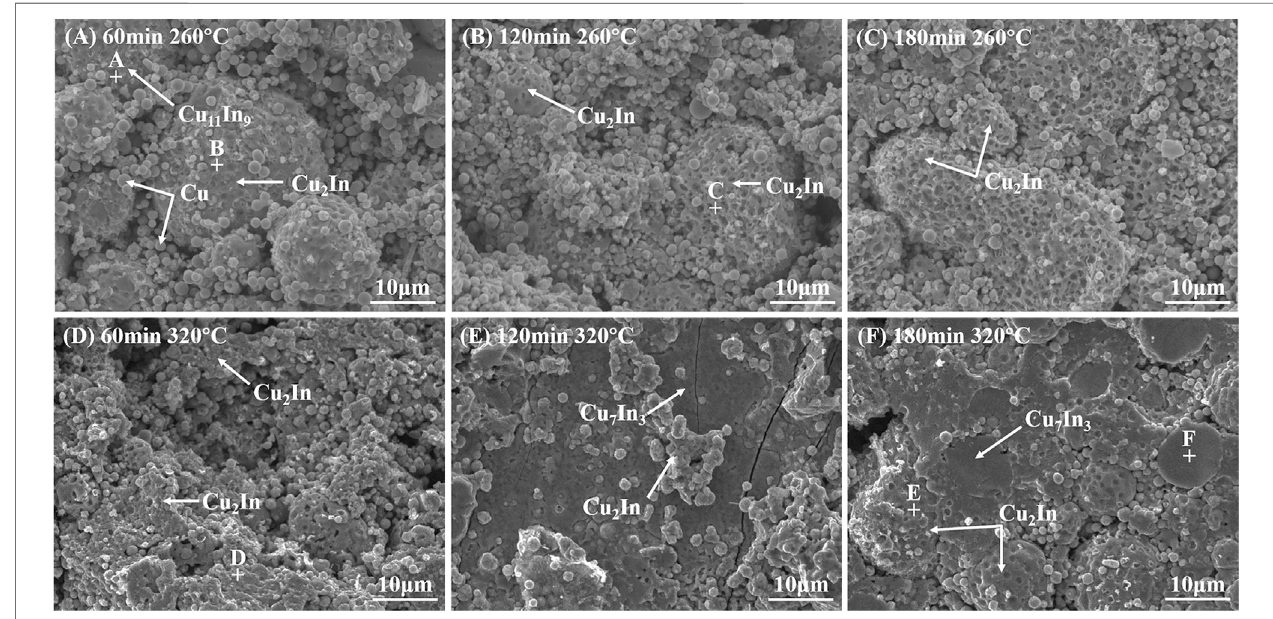
FIGURE 10 | Fracture morphology with different holding times at 260 and 320 ° C: (A) 60 min, (B) 120 min, (C) 180 min at 260 ° C, (D) 60 min, (E) 120 min, (F) 180 min at 320 °